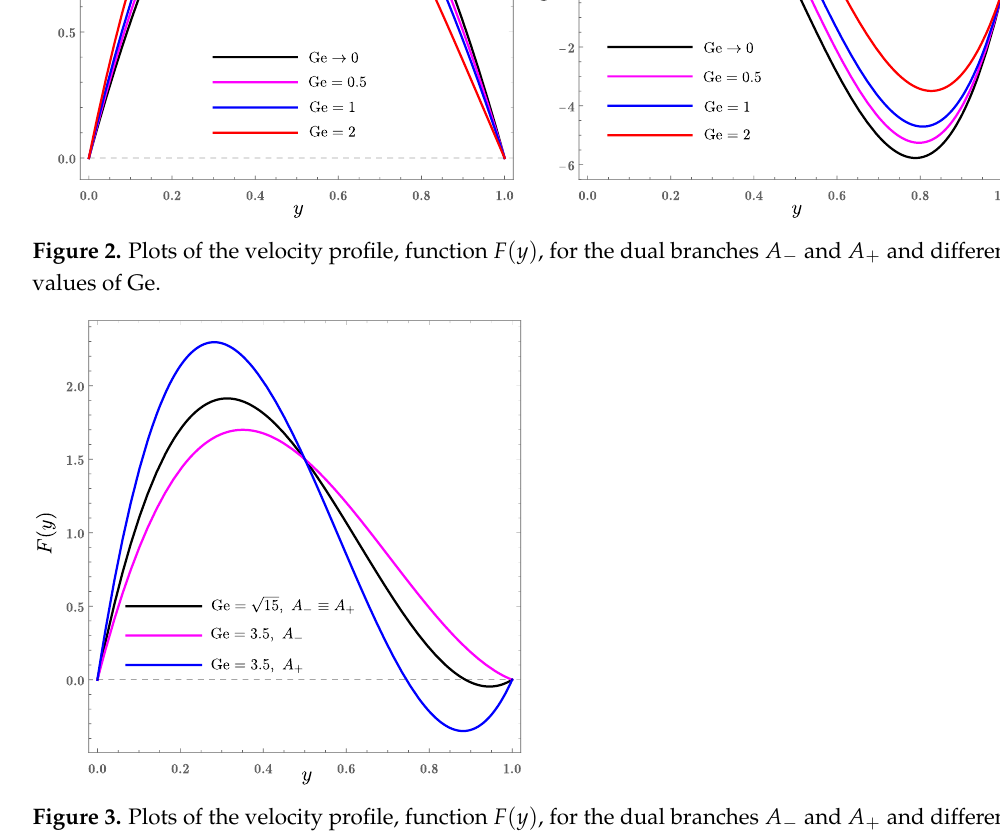
Figure 3. Plots of the velocity profile, function F ( y ) , for the dual branches A − and A + and different values of